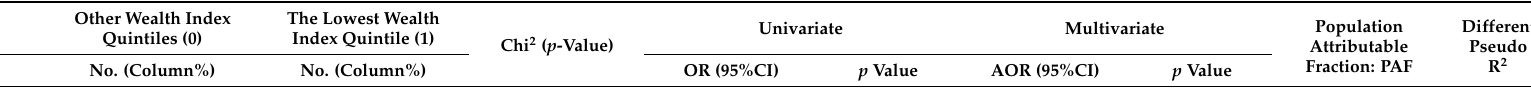
Table 1. The proportion of households in extreme poverty by socioeconomic status (SES), association between being in an extreme poverty household and socioeconomic status, and effect of each SES factor as illustrated by the PAF and different pseudo-R-squared values. Category Other Wealth Index Quintiles (0) The Lowest Wealth Index Quintile (1)